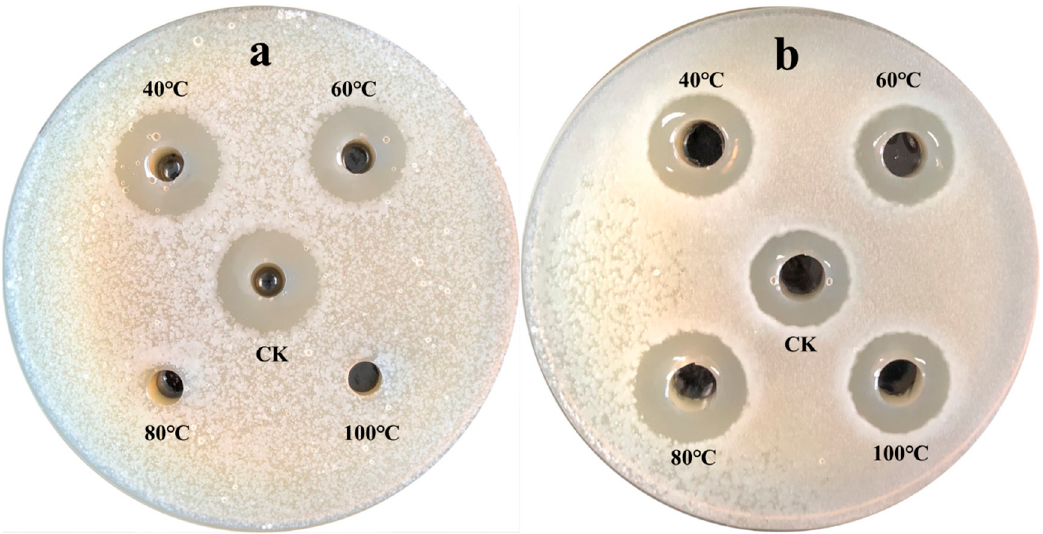
Figure 6. The e ff ect of temperature on the antibacterial activity of the extract of the supernatant ( a ) and cell pellet of strain NEAU-SSA 1 T ( b ) against Ralstonia solanacearum .